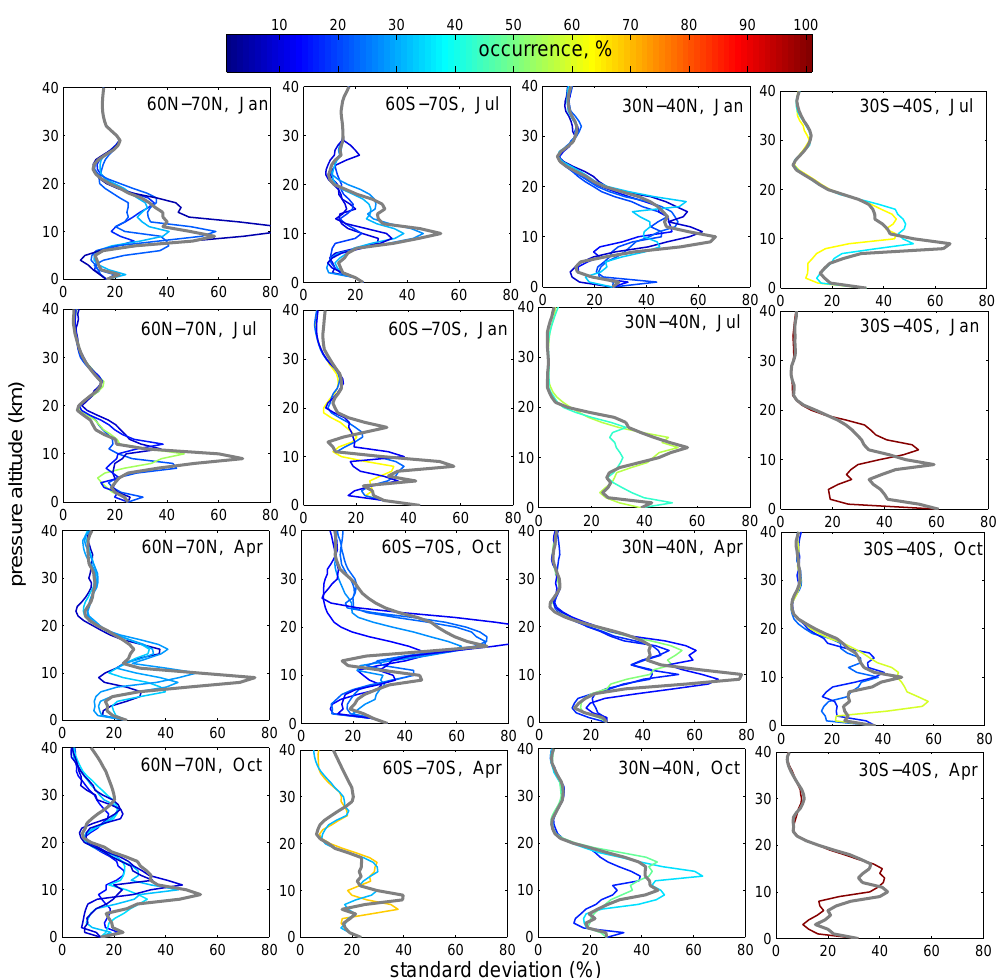
Fig. 11. As in Fig. 9 but for standard deviations. LLM variability is indicated by grey